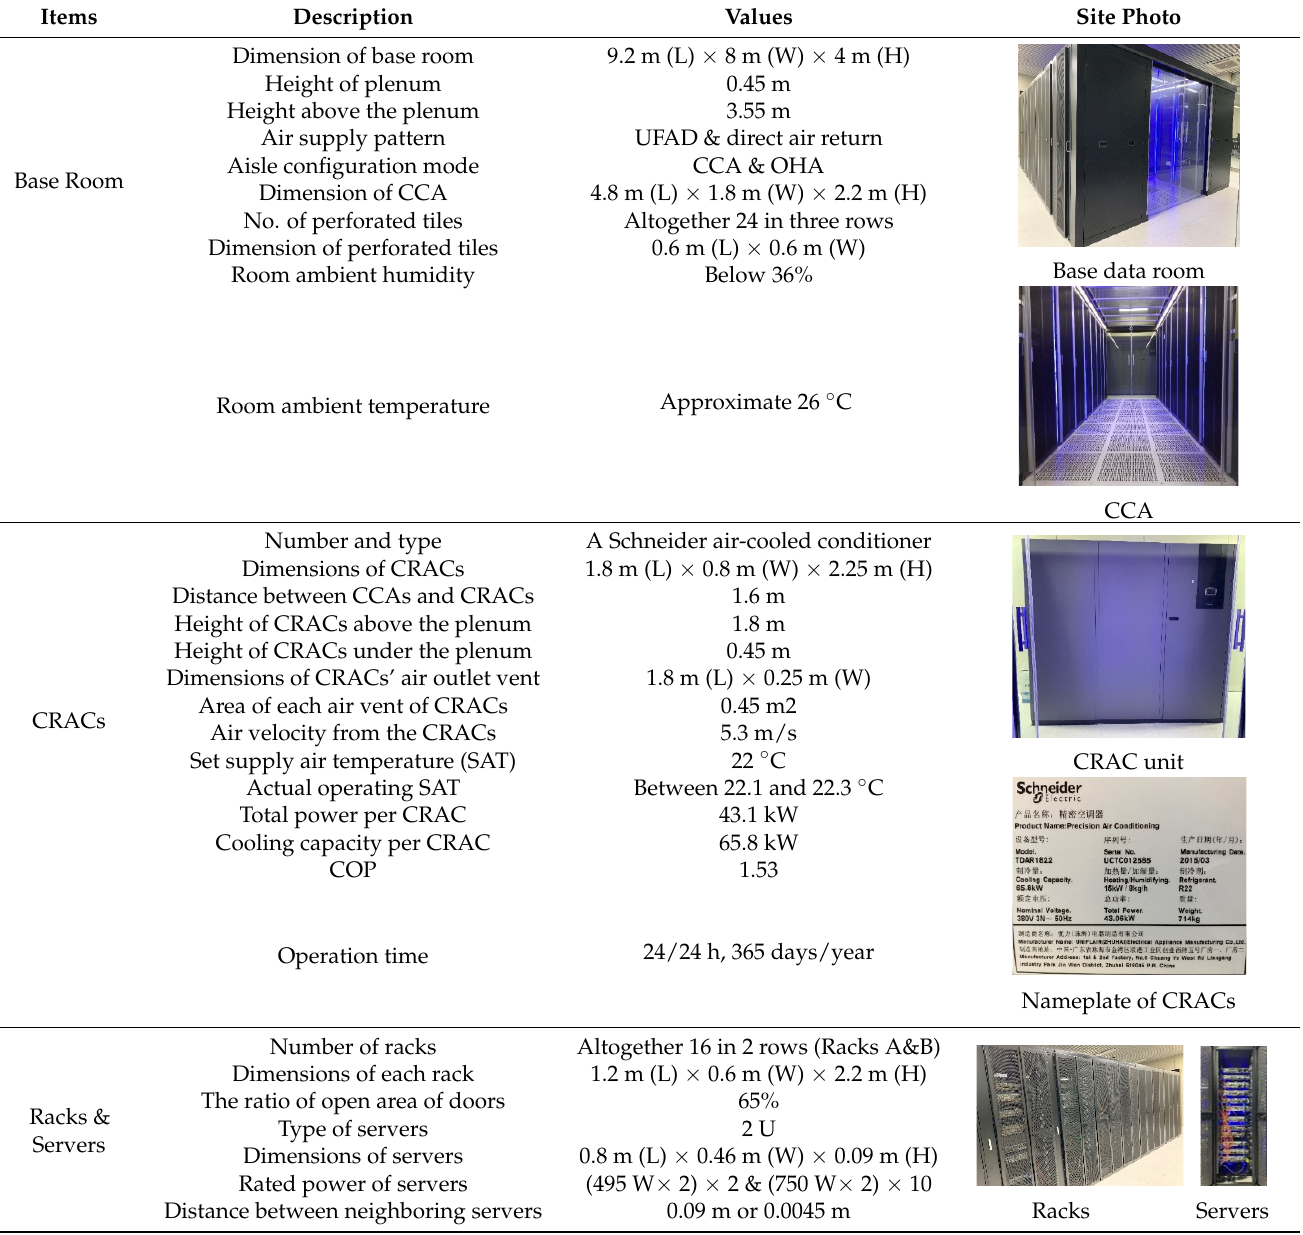
Table 1. Parameters of the base room and its equipment.